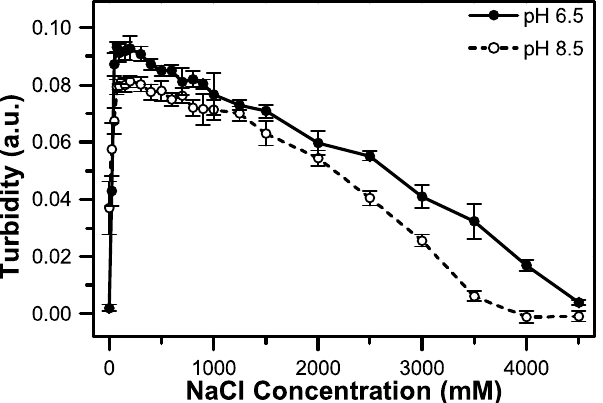
Figure 8. Plot of turbidity as a function of NaCl concentration at pH 6.5 where both polymers are fully charged (closed) and pH 8.5 where the pAA is half-charged (open). All samples were prepared at 1 mM total monomer concentration, and charge-neutral conditions (50/50 mol% pAA/pAH at pH 6.5 and 33/67 mol% pAA/pAH at pH 8.5). Complexes were prepared by adding pAA to a solution containing a mixture of pAH and the desired quantity of salt.